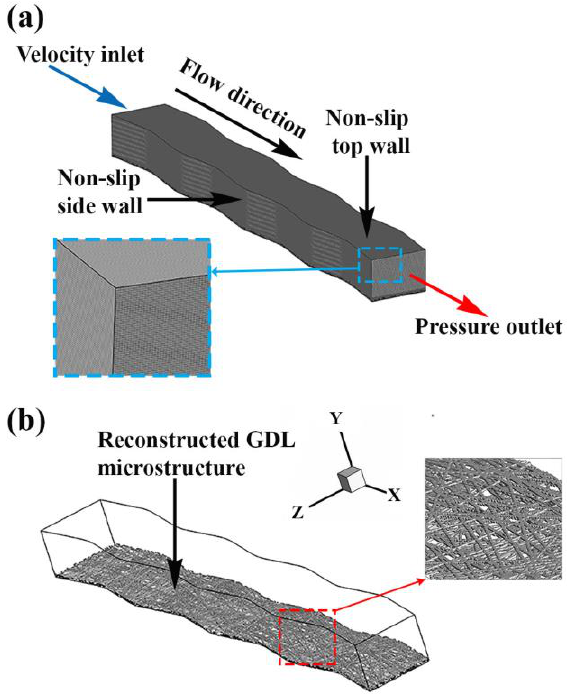
Figure 3. Computational domain. ( a ) Boundary conditions; ( b ) reconstructed GDL microstructure patched to the channel bottom.